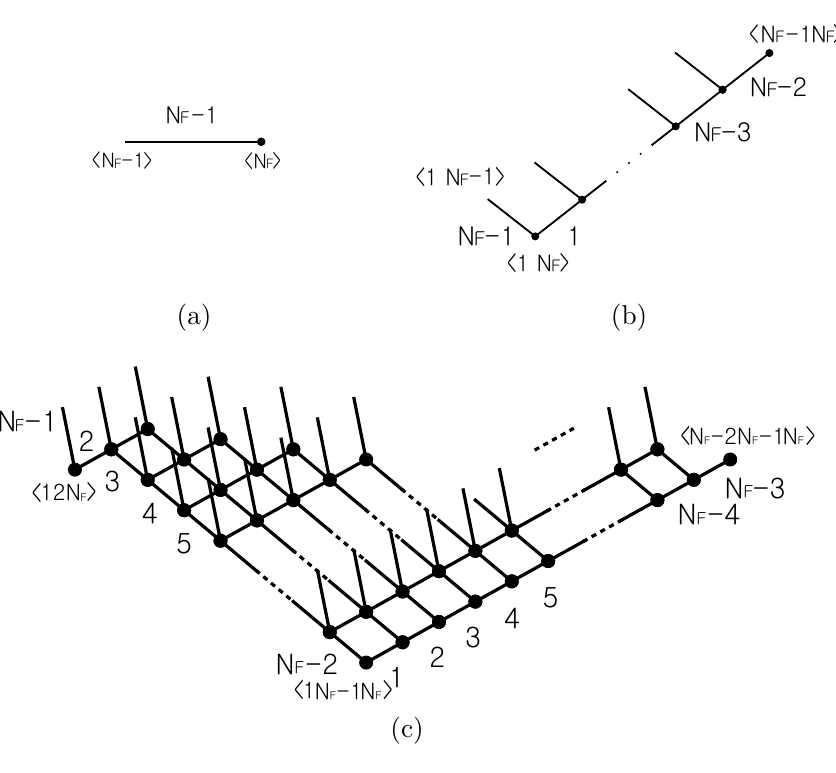
Figure 2 . (a) N C = 1; (b) N C = 2; (c) N C =